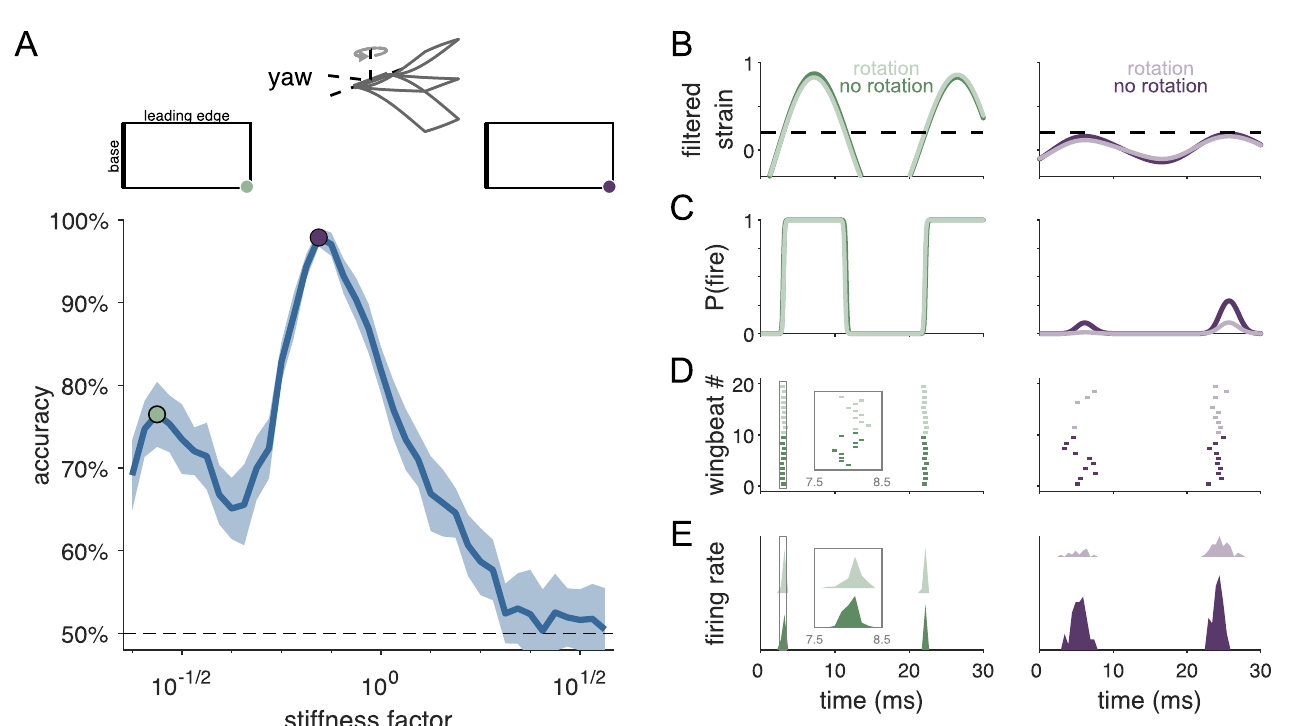
Fig 2. Wing stiffness interacts with neural threshold to determine spike timing. A: Accuracy as a function of wing stiffness. Chance accuracy is 50%, and stiffness factor 1 corresponds to 3 GPa, comparable to experimentally measured stiffness in the hawkmoth [28]. Green and purple dots indicate local peaks in accuracy. Shaded area indicates ± 1 standard deviation. Top : Center schematic indicates the direction of rotation. Left and right schematics show the location of the single best sensor for each stiffness value. B: Filtered strain over a single wingbeat for flapping only (“no rotation”) and flapping with rotation (“rotation”) conditions at a single sensor location. Green and purple sensor locations in A correspond to left/green and right/purple filtered strain. Dashed horizontal line indicates the threshold (value at half-max) of the neural encoding nonlinearity. C: Filtered strain passed through the nonlinear function gives probability of spiking over time, P(fire). D: Spiking responses for 10 wingbeats each of the no rotation and rotation conditions. Spikes are generated probabilistically from P (fire), resulting in variable spike timing from wingbeat to wingbeat. Inset : Magnified view of the first firing event, surrounded by gray box, between 7.5 and 8.5 ms. E: Histogram of spike times (PSTHs) for each condition, summarizing spike timing over hundreds of wingbeats.